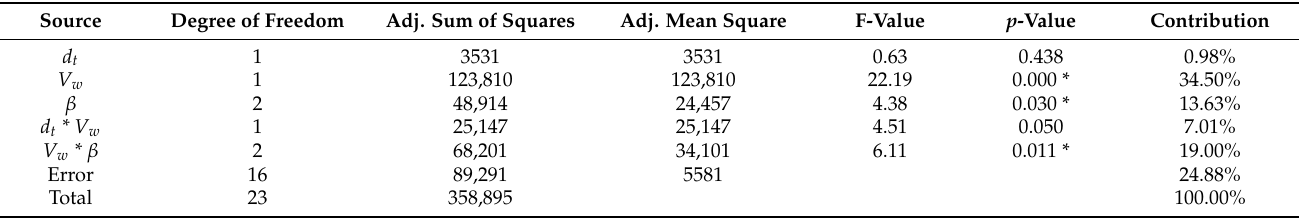
Table 5. ANOVA test for average surface roughness ( R a